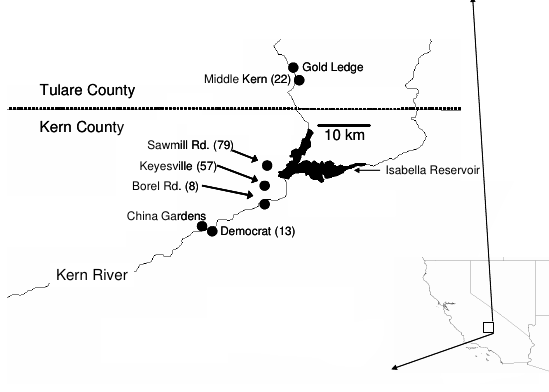
F IG . 1. Locations of C. xantiana ssp . xantiana populations (in California, USA) used for pollinator observations and nectar